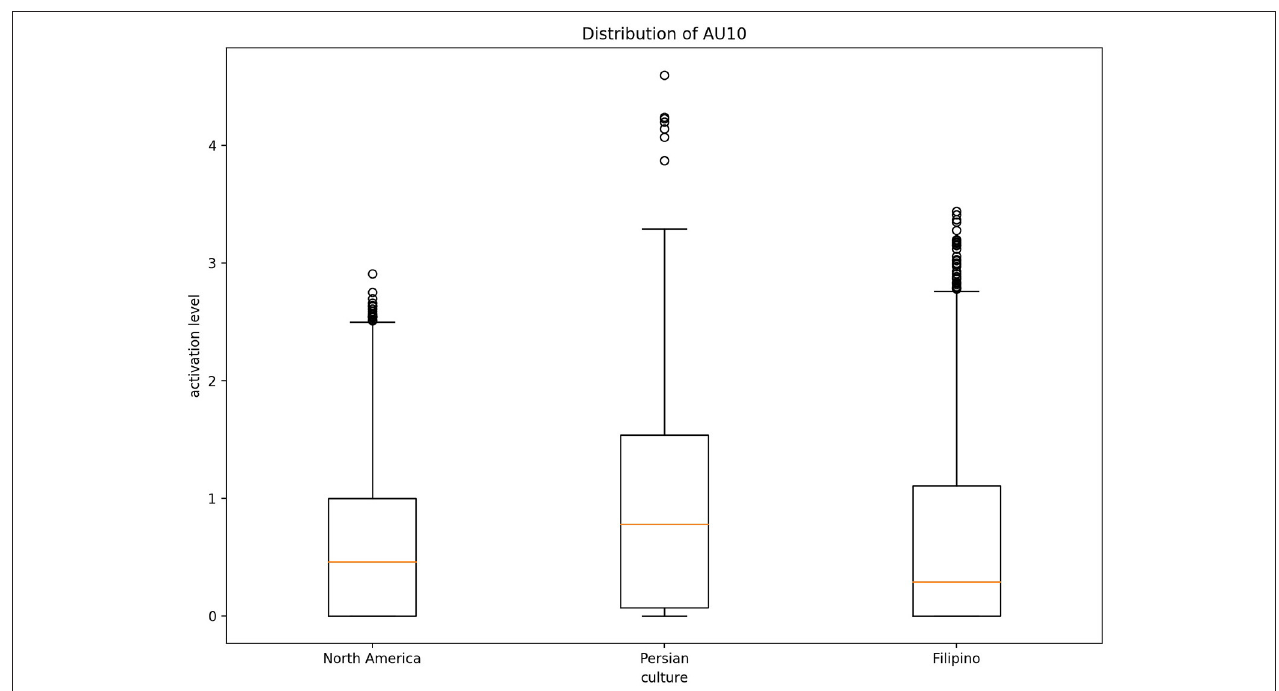
FIGURE 4 | Distribution of AU10 cross-culturally for contempt.